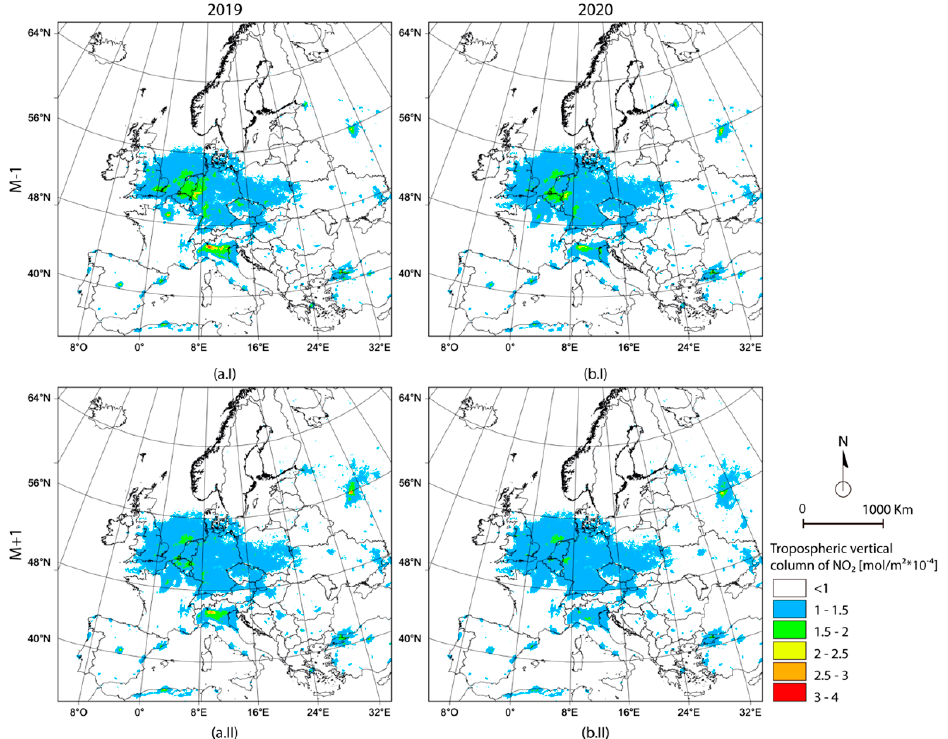
Figure 3. Comparison in Europe of the evolution of the average NO 2 content in the troposphere one-month ( I ) before and ( II ) after March 15, ( a ) 2019 and the same period in ( b ) 2020.